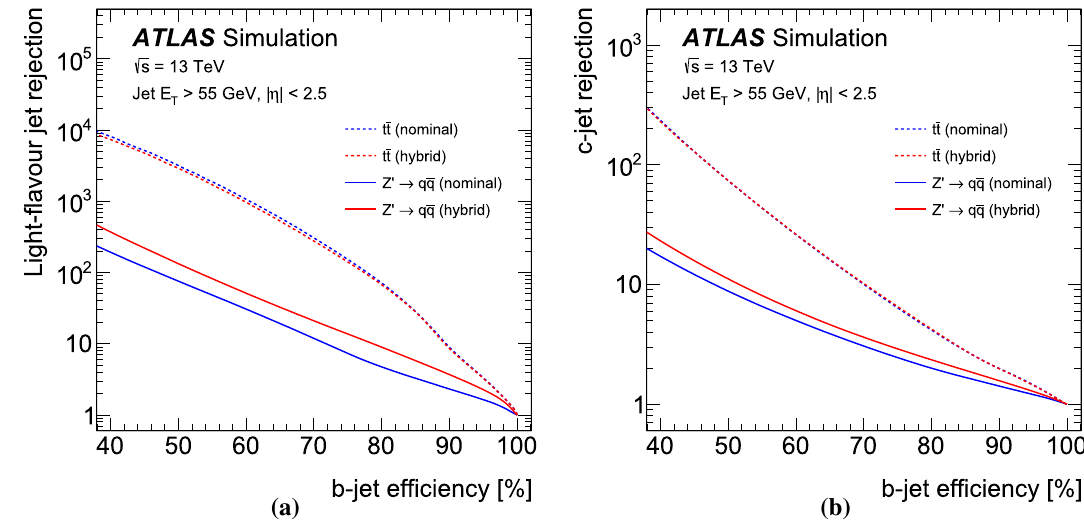
Fig. 11 The expected performance of b -tagging algorithms using the nominal and hybrid tunings, using simulated t ¯ t and Z (cid:7) → q ¯ q events. The a light-flavour jet and b c -jet rejection factors are shown as a function of b -jet selection